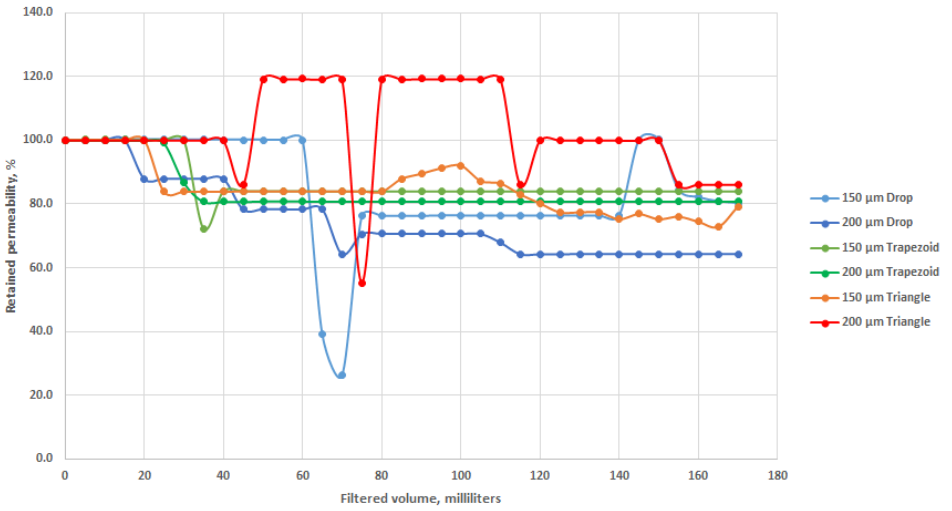
Figure 9. Retained permeability of screens in percent.